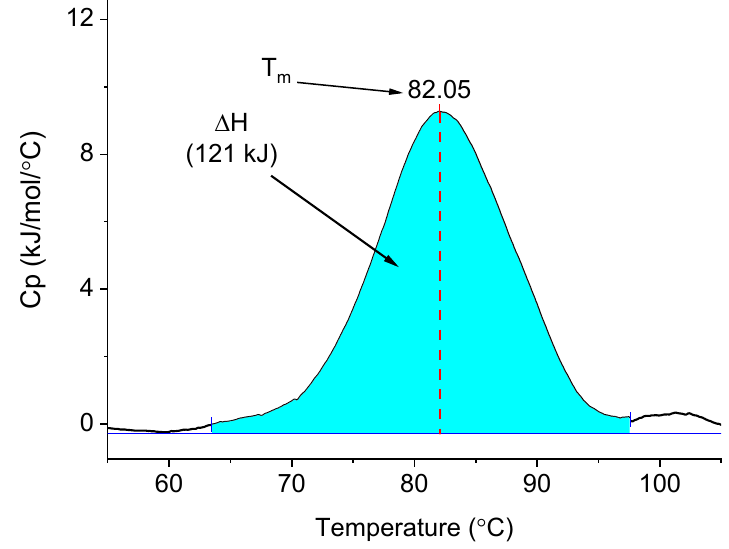
Figure 1. DSC data for CSP obtained at pH 10.5 in aqueous solution. The thermogravimetric curves and first-derivative thermograms are shown in Figure 2. The TGA and DTG traces for paper and paper treated with CNMs but not CSP are very similar, as are all the samples treated with CSP with and without the presence of CNM. The trace of CSP has a low T onset and produces significant (>30%) char residue. CSP was shown to thermally degrade over a broad temperature range, with an initial T onset of ~280 ◦ C, consistent with prior results [29]. However, the filter paper and paper treated with only cellulose nanomaterials exhibit a sharp thermal degradation with a T onset of ~340 ◦ C, which is expected given their entirely cellulosic composition (See Table 2, for details)